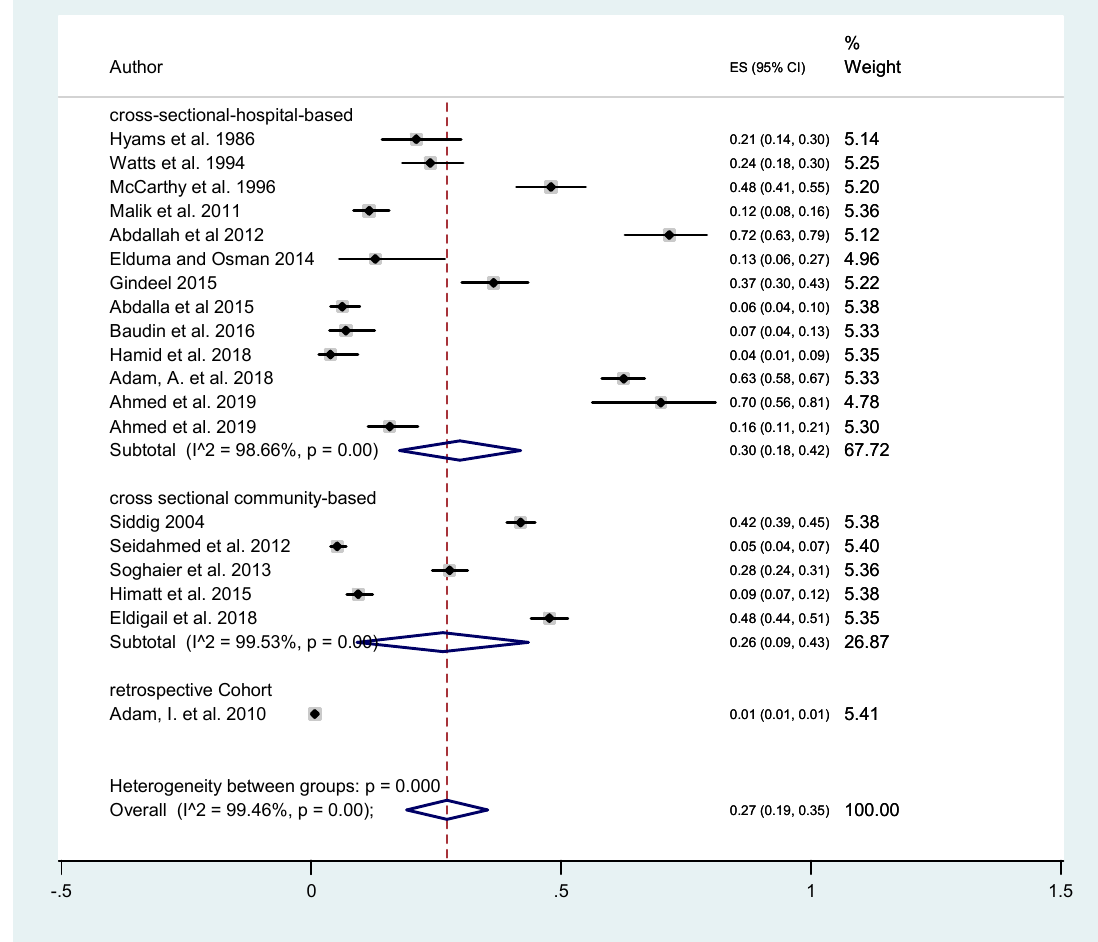
Heterogeneity between groups: p = 0.000 Overall (I^2 = 99.46%, p = 0.00);